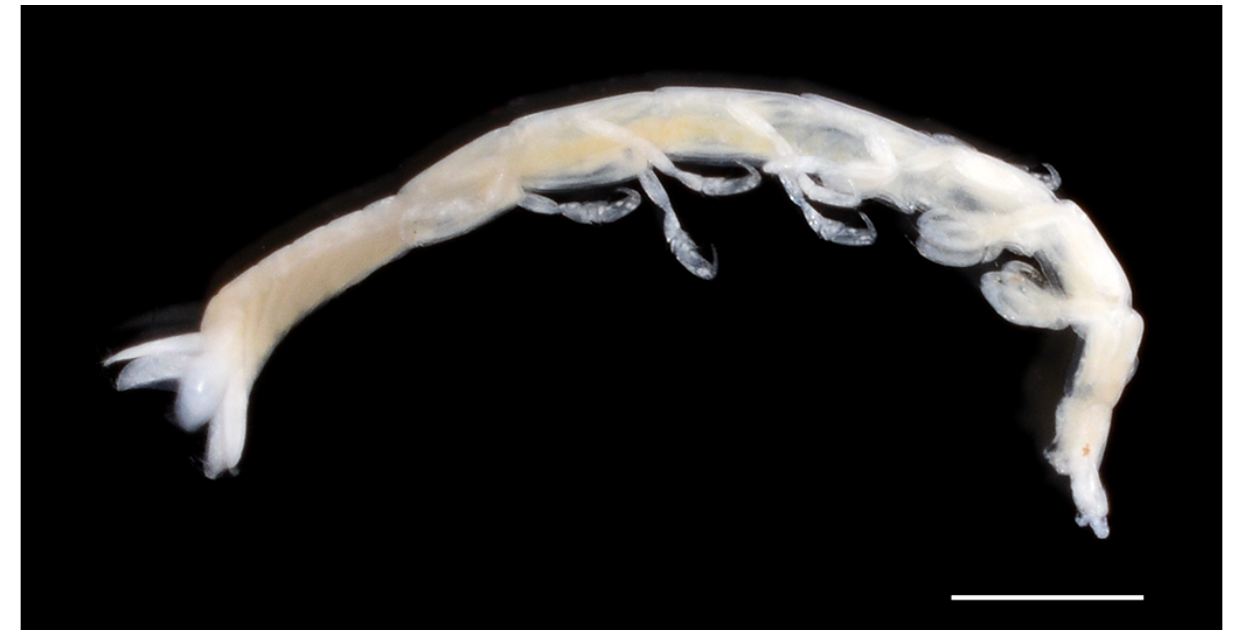
Figure 1. Kupellonura tamago sp. nov., holotype, female, lateral view of fixed specimen. Scale bar: 1